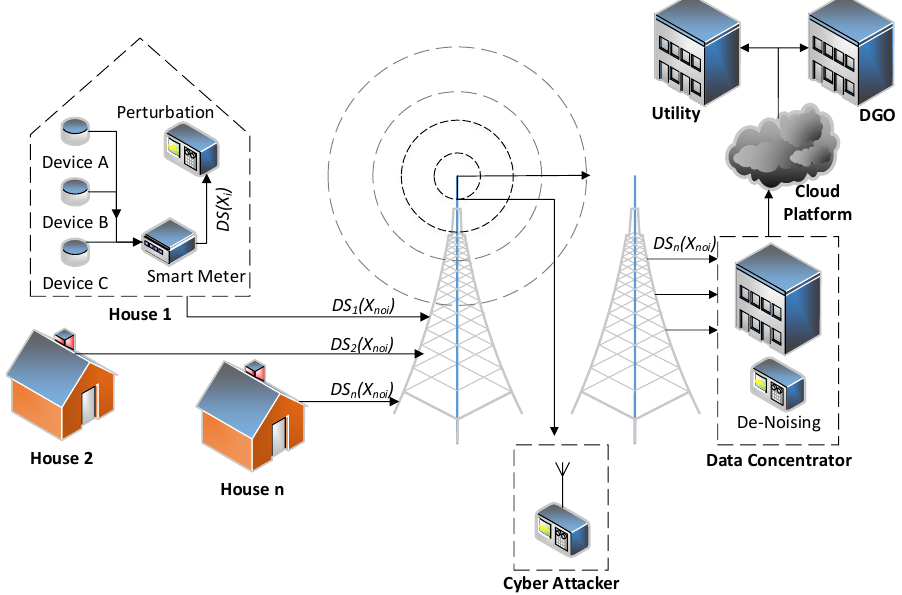
Figure 4. Schematic illustration of the data transmission system, using the example of approach